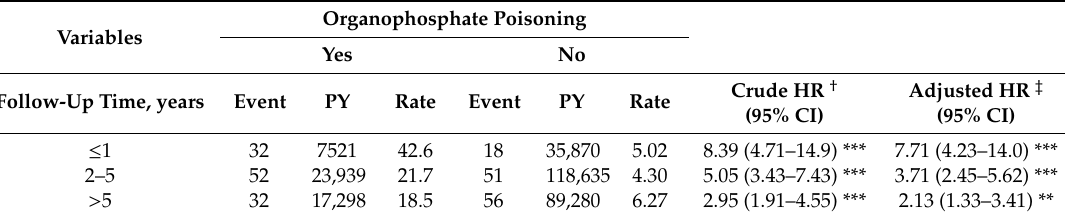
Table 4. Trends of seizure event risk stratified by follow-up